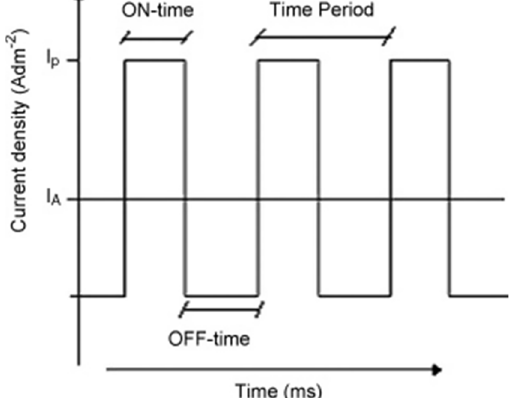
Figure 6. The typical pulse–current waveform showing T on and T off for one cycle. Reproduced with permission [70] . Copyright 2008, Elsevier.